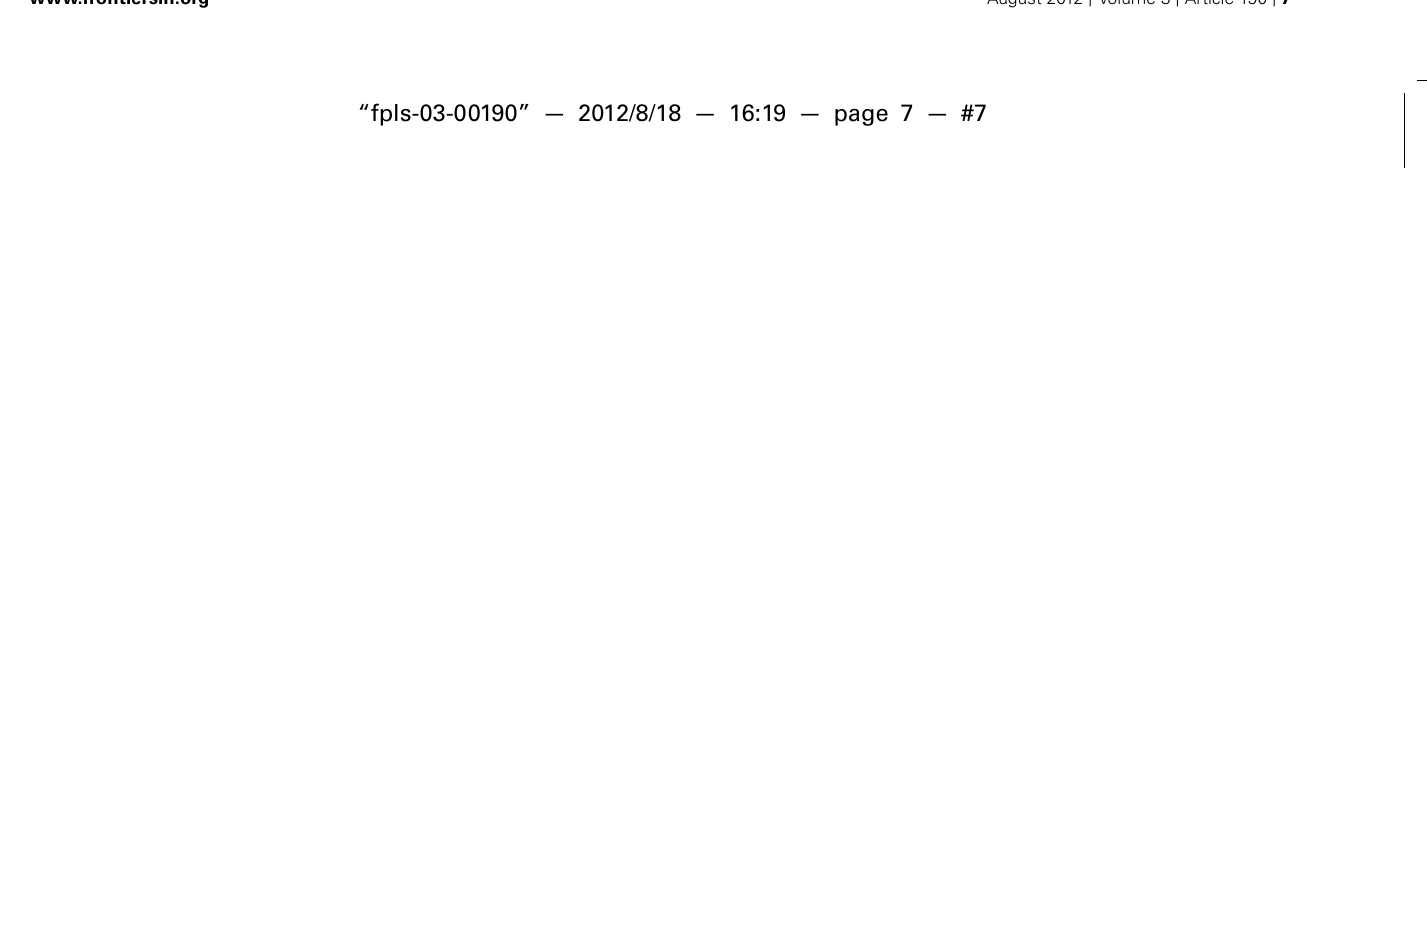
FIGURE 5 | Representative charts showing similarity in the 14-3-3 isoform genes expression pattern across different plant tissue in Arabidopsis thaliana based on selected microarrays expression data fromArrayExpress database. The experiment IDs in ArrayExpress database are provided in the chart title. Gene expression data was analyzed for only untreated, wt, Colombia cultivar plants. Y axis raw expression units relative to UBQ11 (At4g05050). Data from E-MTAB-1009 and E-GEOD-30096 was used to plot 14-3-3 isoform genes expression level across whole shoots, hypocotyls, and roots as well as root zones.The distance in the legend defines the distance from the root tip (A) .The two independent experiments were analyzed, E-GEOD-5526 and E-MEXP-695 to plot 14-3-3 isoform genes